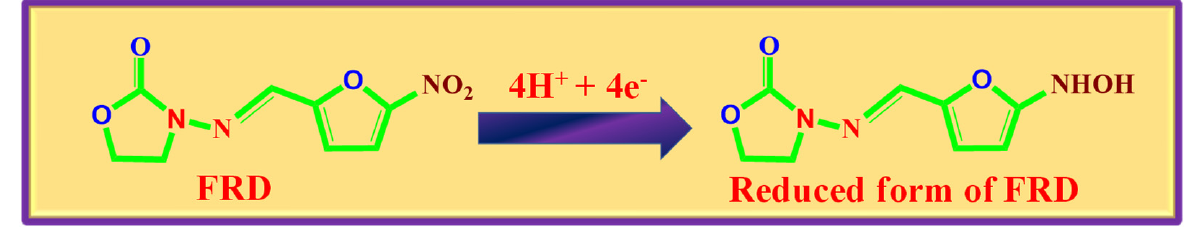
Scheme 2. The reduction mechanism of FZE.